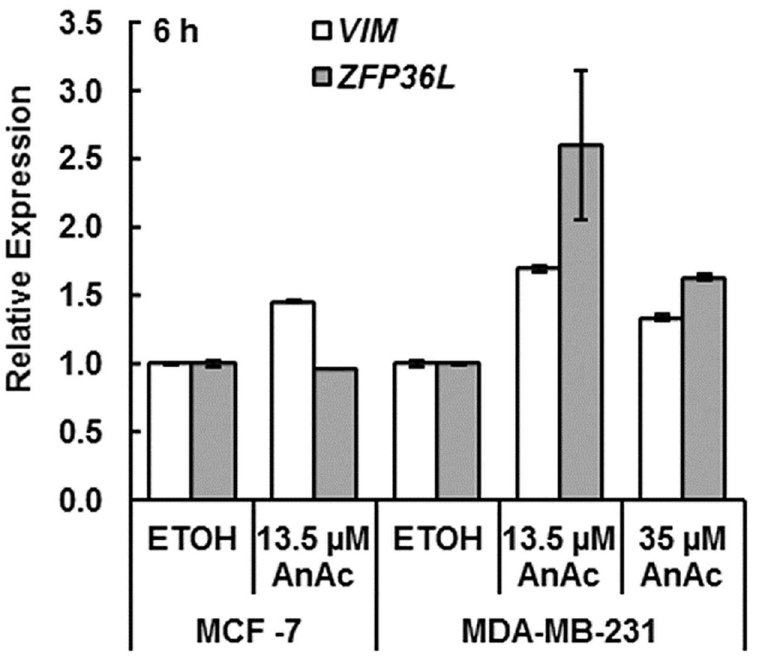
Fig 5. qPCR analysis of mRNA targets of AnAc-downregulated miRNAs. MCF-7 and MDA-MB-231 cells were grown in hormone-depletedmedium for 48 h prior to 6 h treatment with 13.5 or 35 μ M AnAc. qPCR was performed using GAPDH as normalizer. Values are the mean ± SEM of triplicatesin one experimentfor MCF- 7 cells and are the mean ± SEM of two independent experiments for MDA-MB-231 cells.